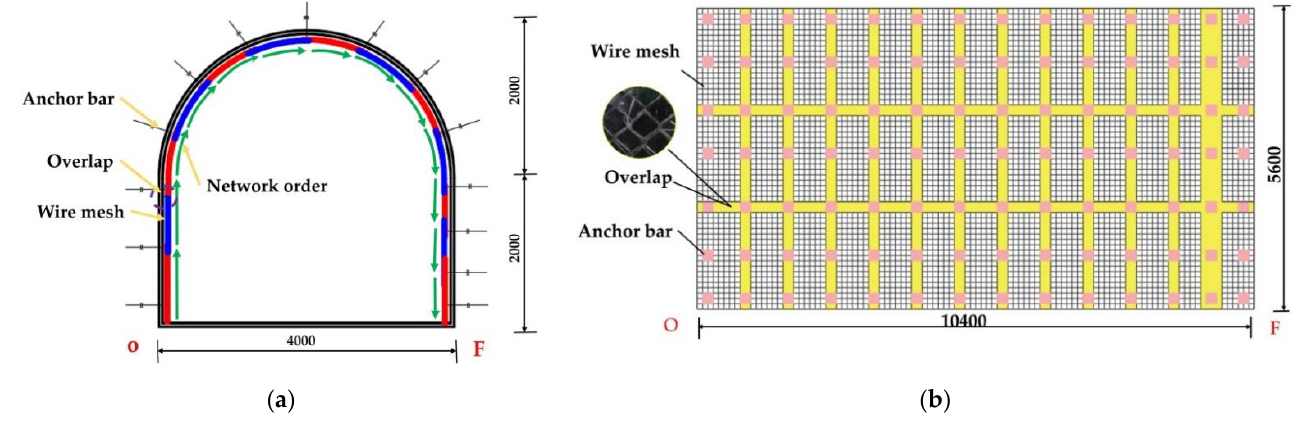
Figure 15. Construction diagram of wire mesh laying: ( a ) schematic diagram of the profile; ( b ) schematic diagram of section unfolding.